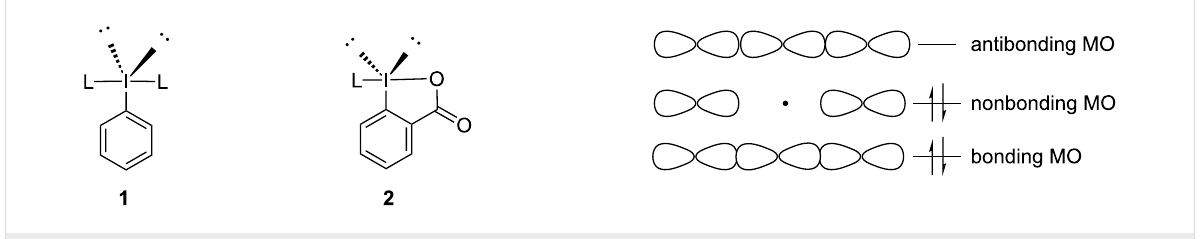
Figure 1: The structures of hypervalent iodine (III) reagents